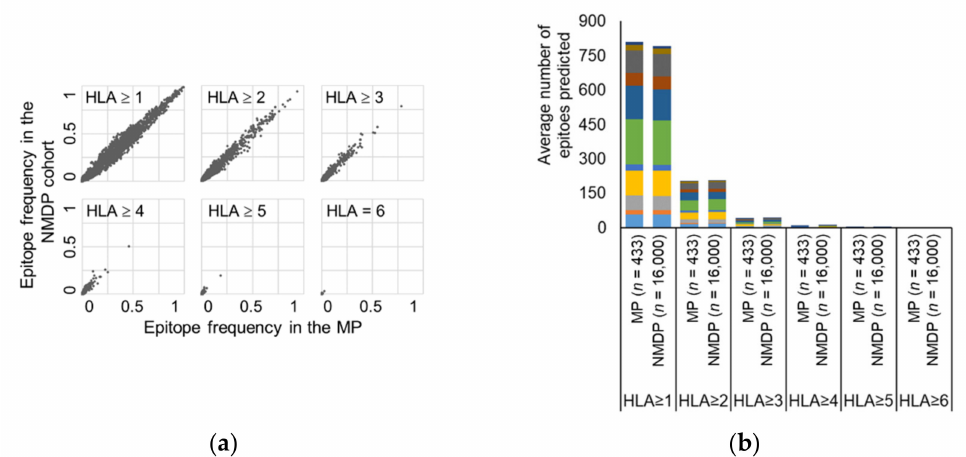
Figure 2. Representativeness of the in silico model cohort (MP) demonstrated by the correlation of epitope-binding capabilities with the NMDP cohort of 16,000 subjects. ( a ) Frequency of MP versus NMDP cohort subjects predicted to bind 9-mers of the 11 protein antigens for the six different cut-offs: HLA ≥ 1 alleles ( r = 0.9897, p < 10 − 102 ), HLA ≥ 2 alleles ( r = 0.9903, p < 10 − 102 ), HLA ≥ 3 alleles ( r = 0.9849, p < 10 − 102 ), HLA ≥ 4 alleles ( r = 0.9611, p < 10 − 102 ), HLA ≥ 5 alleles ( r = 0.9401, p = 4.7 × 10 − 102 ), or HLA = 6 alleles ( r = 0.8742, p = 1.8 × 10 − 39 ). Each point represents a possible 9-mer epitope of the selected 11 protein antigens. ( b ) Average number of epitopes predicted for the six different cut-offs: binding to ≥ 1, ≥ 2, ≥ 3, ≥ 4, ≥ 5, or =6 autologous HLA alleles for the 11 proteins; MAGE-A3 ( (cid:4) ), survivin ( (cid:4) ), WT1 ( (cid:4) ), GP100 ( (cid:4) ), NY-ESO-1 ( (cid:4) ), HER2 ( (cid:4) ), MUC1 ( (cid:4) ), P53 ( (cid:4) ), Tyrosinase ( (cid:4) ), HPV-16 E6 ( (cid:4) ) and HPV16-E7 ( (cid:4)